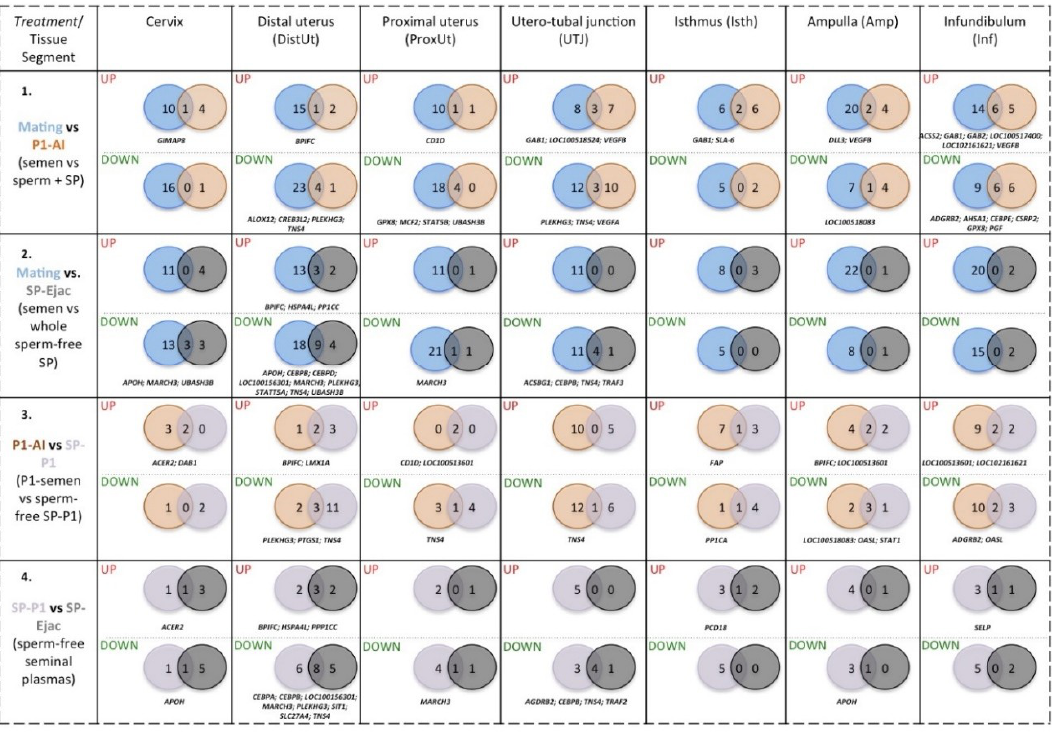
Figure 2. Venn diagrams displaying numbers of differentially expressed genes of immune function (up- or down-regulated, p < 0.05) in the internal genital tract of sows, comparing the various treatments used (1). Semen (spermatozoa and SP) from the entire ejaculate (Mating) or the sperm-rich fraction (P1-AI); (2). Semen (spermatozoa and SP) from the entire ejaculate (Mating) or its sperm-free entire SP (SP-Ejac); (3). Semen (spermatozoa and SP) from the sperm-peak fraction (P1-AI) or its sperm-free SP (SP-P1); SP (sperm-free) from the sperm-peak fraction (SP-P1) or from the whole ejaculate (SP-Ejac). The acronyms of genes common to treatment per tissue (crossing sectors) are identified.